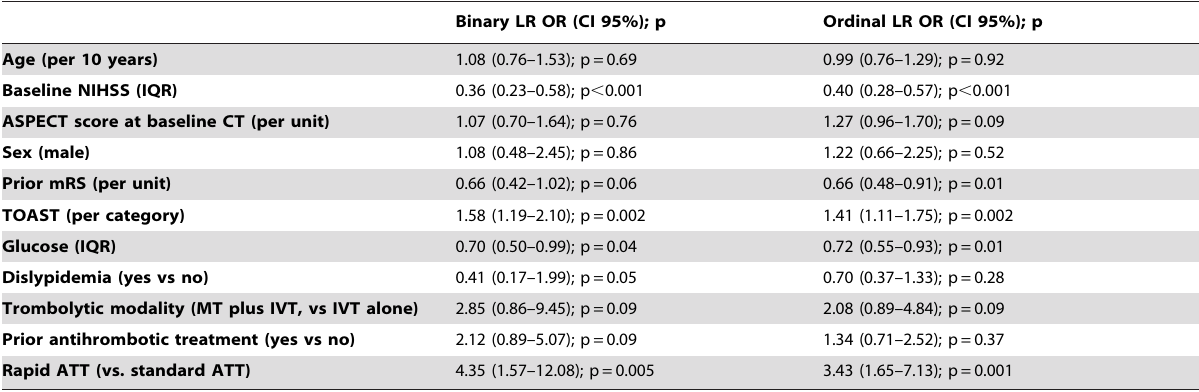
Table 3. Multivariate analysis of outcome.